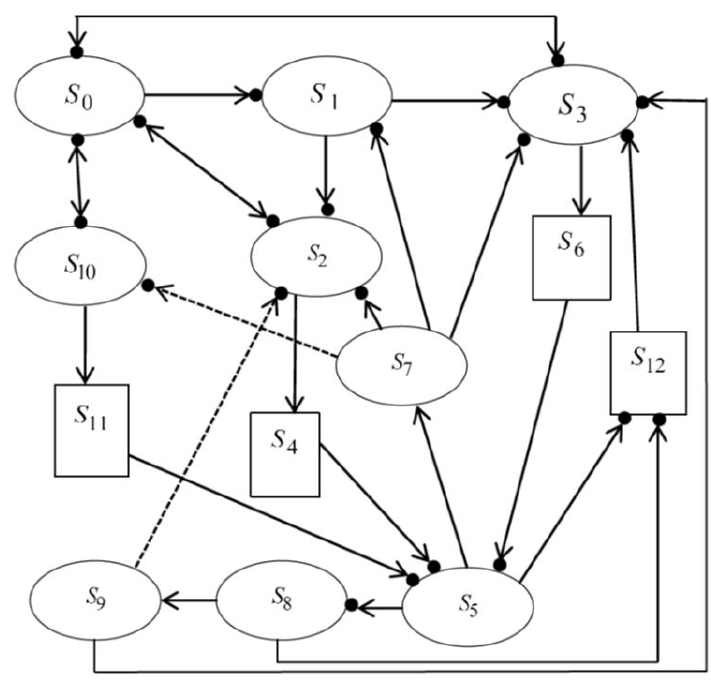
Figure 1. The Transitions Fig. 2: The MTSF of the system based on different parameter values